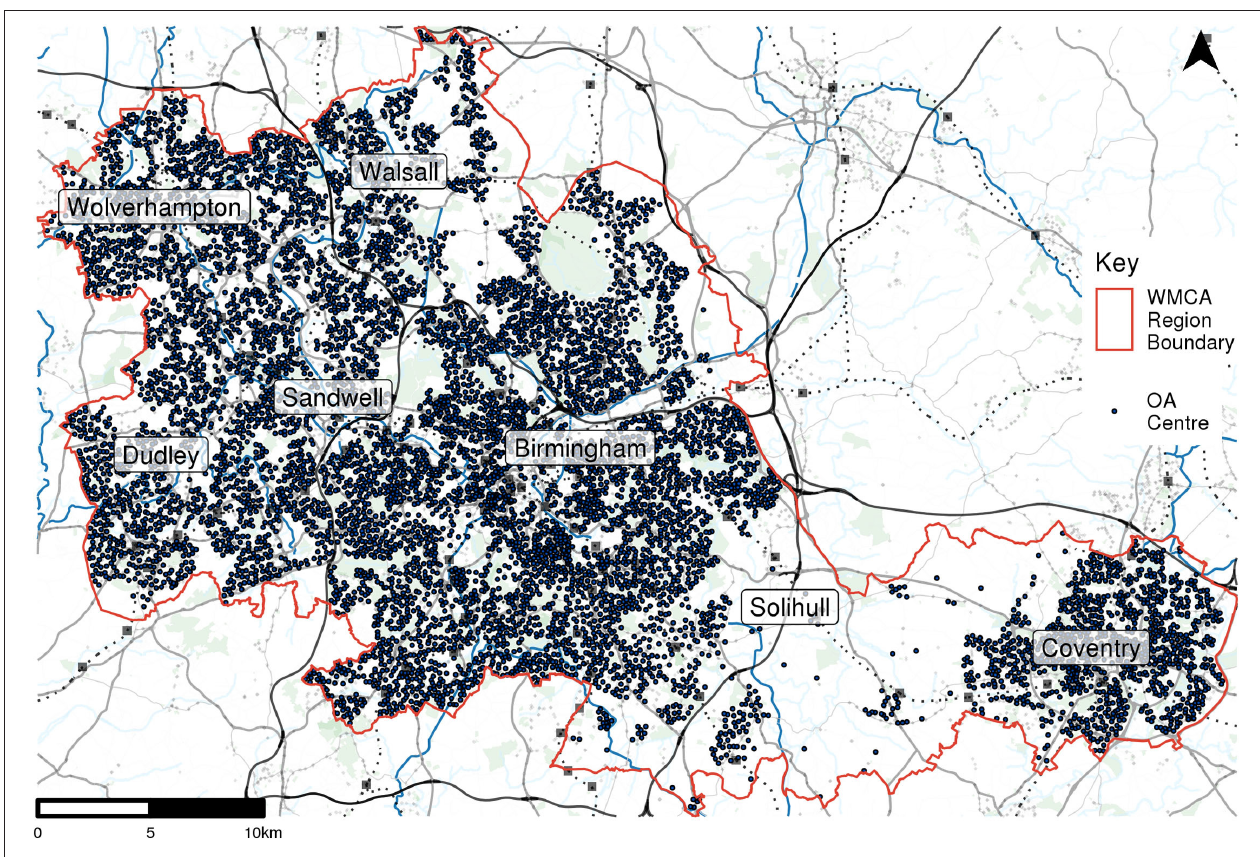
FIGURE 3 | Centroid locations of UK census output areas.